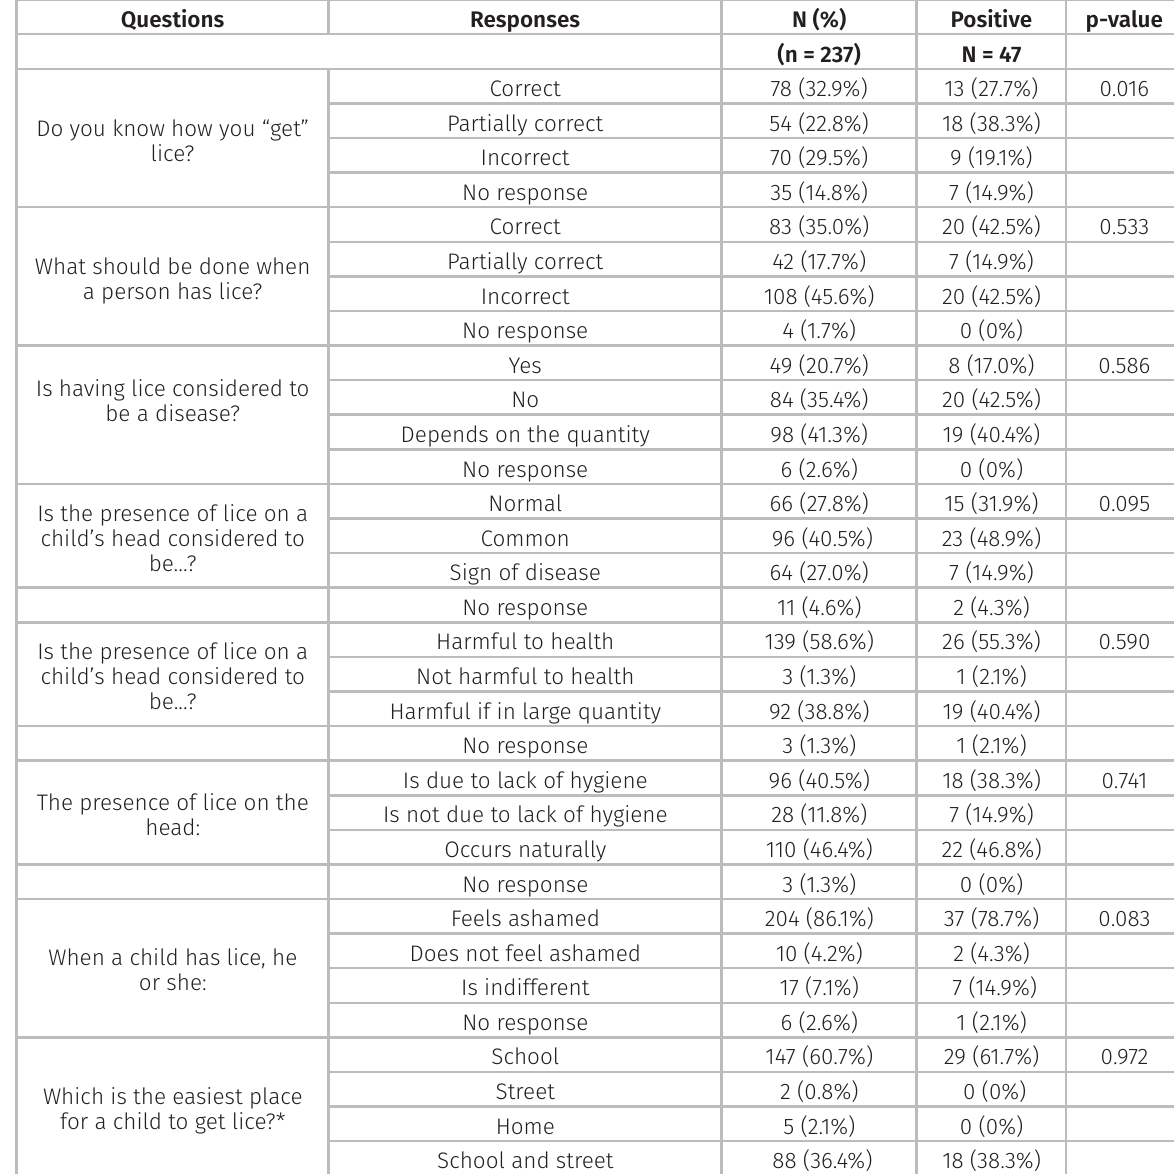
Table IV. Results regarding knowledge about pediculosis among the parents and guardians and positivity among their children in years 1-5 at five municipal elementary schools in Niterói, RJ,